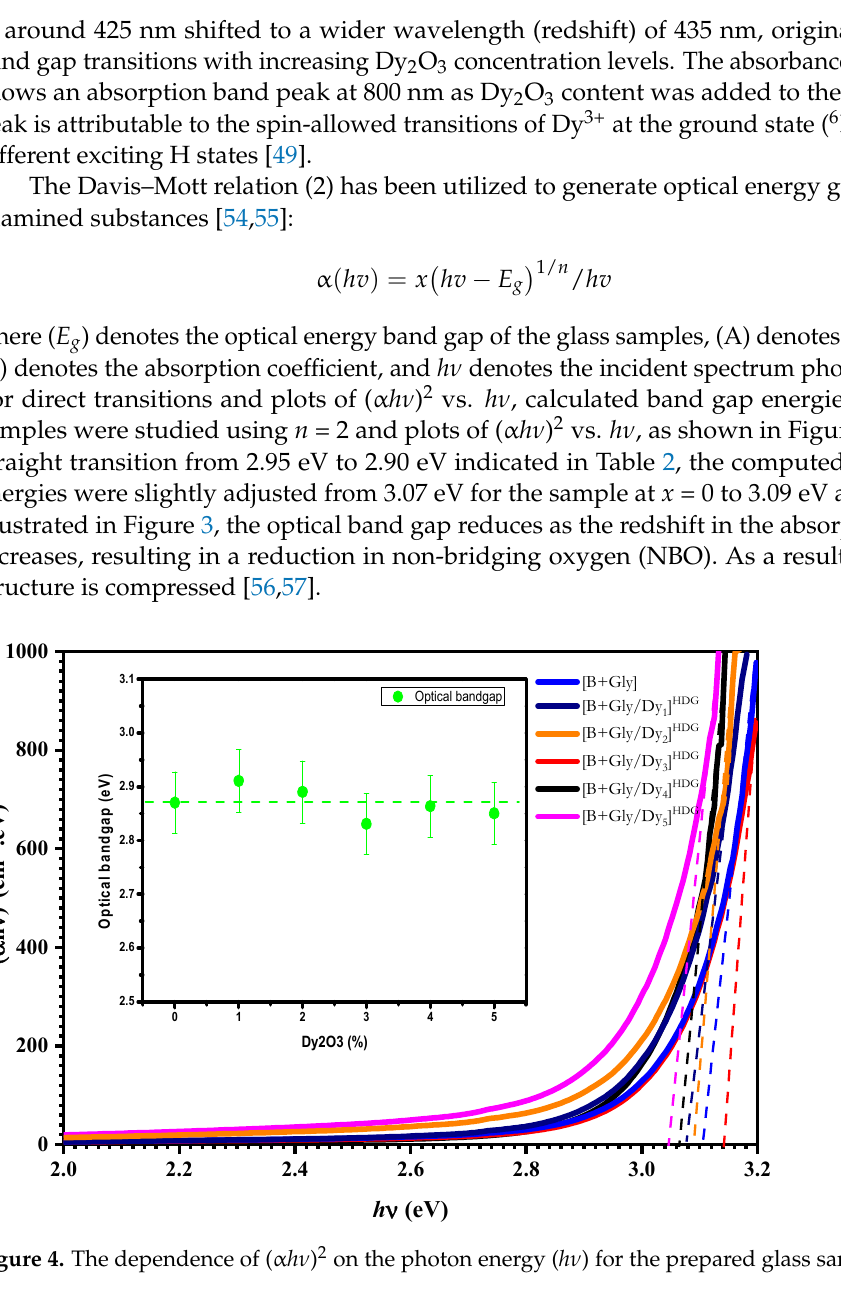
Table 2. Concentration ( C ), Urbach energy ( E u ), energy gap indirect ( E OIn ), energy gap direct ( E OD ), linear refractive index ( n ), ( 𝜒 (cid:2869) , 𝜒 (cid:2871) ) linear and third-order nonlinear optical susceptibility for the prepared glass samples .